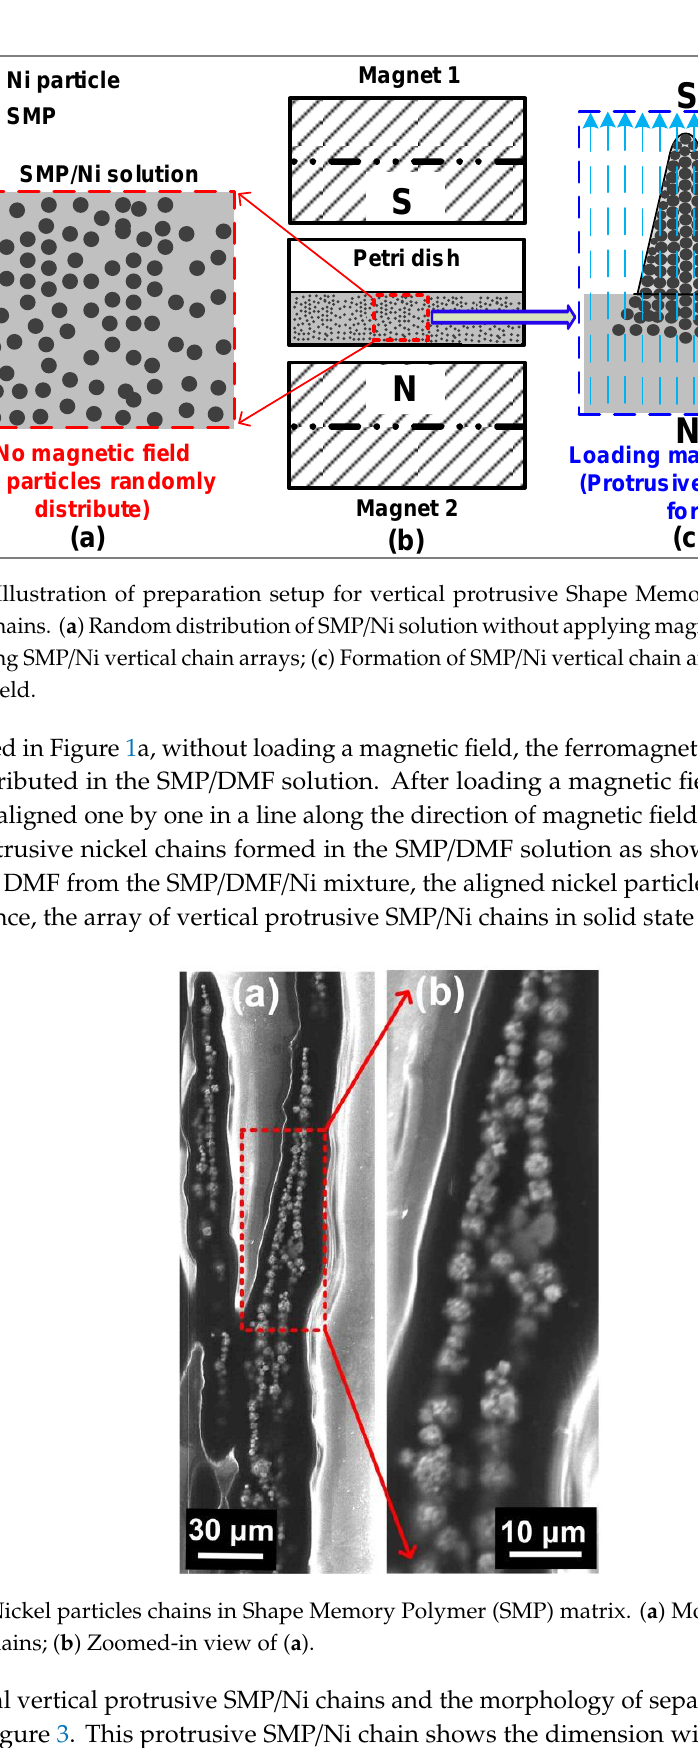
Figure 2. Nickel particles chains in Shape Memory Polymer (SMP) matrix. ( a ) Morphology of nickel particles chains; ( b ) Zoomed-in view of (a).